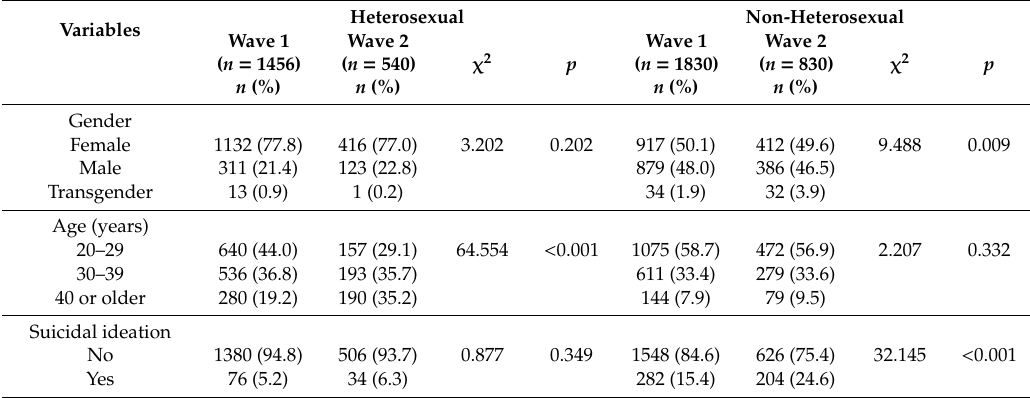
Table 1. Comparison of demographic characteristics and suicidal ideation rates in heterosexual and nonheterosexual participants between the Wave 1 and Wave 2